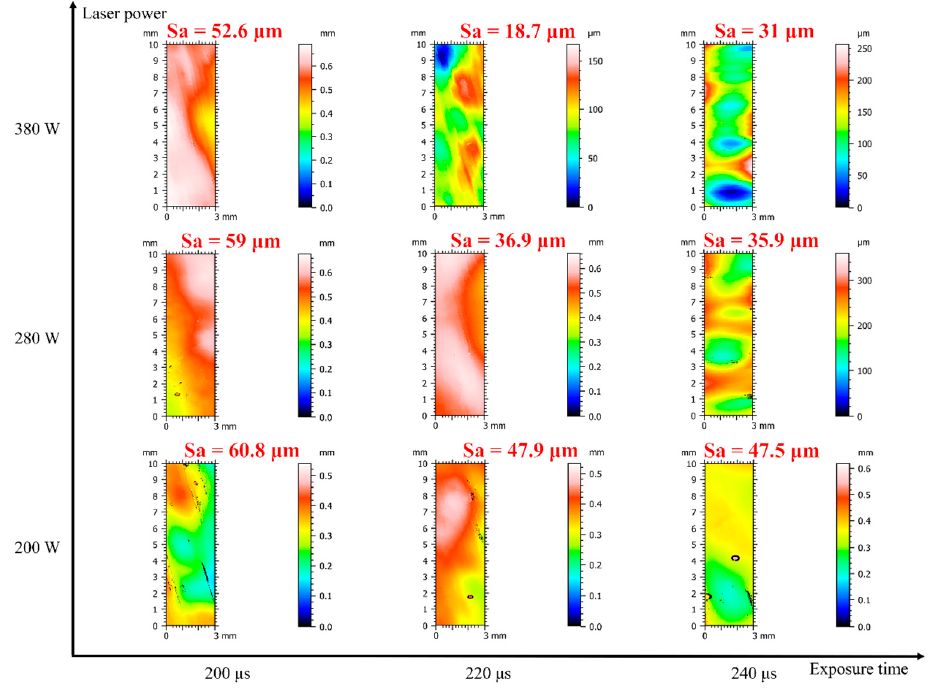
Figure 10. Surface roughness of specimens under different parameters of 150 μ m layer thickness.